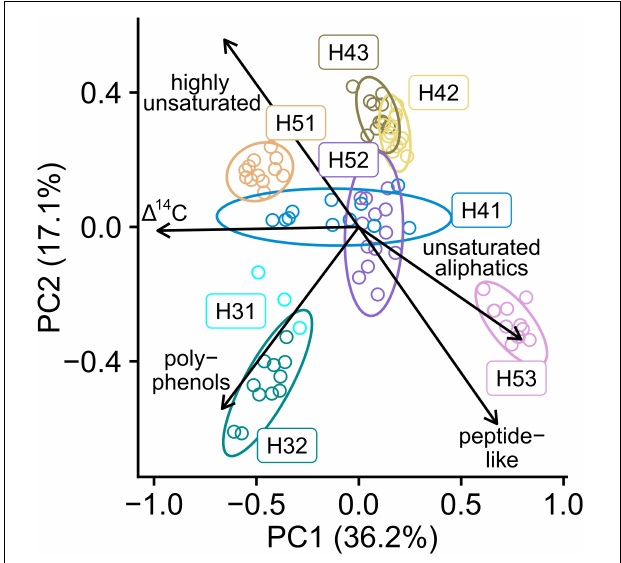
FIGURE 3 | Principal component analysis (PCA) graph based on the molecular composition of SPE-DOM in the Hainich Critical Zone aquifers. (cid:49) 14 C values and relative proportions of major molecular subgroups were fitted as vectors indicating the direction of the strongest increasing gradients.